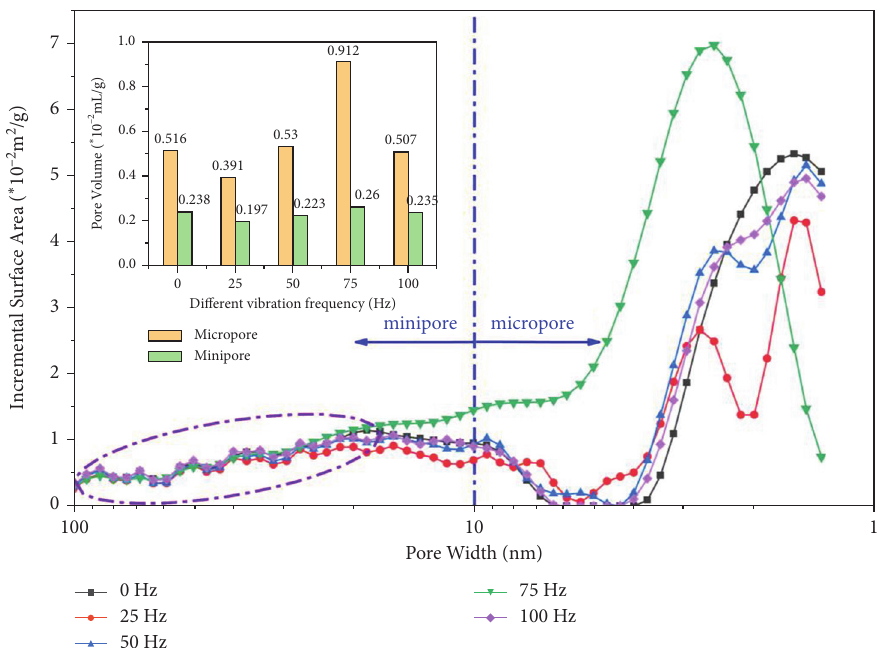
Figure 8: Distribution of the specific surface area of minipores and